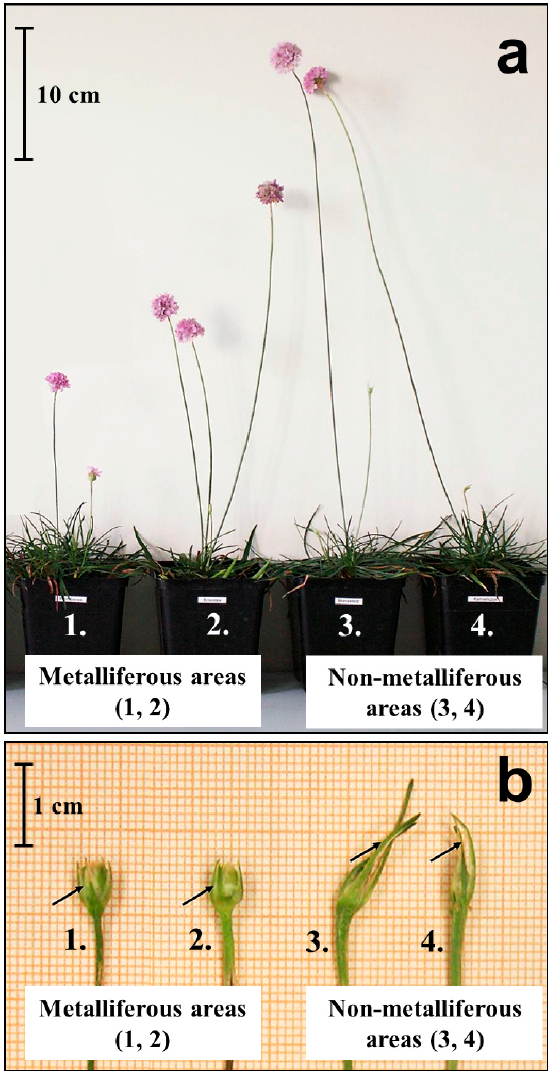
Figure 3. Morphological diversity of A. maritima plants grown in a greenhouse (generation F1) from seeds collected in metalliferous (1—zinc–lead slag heap from Plombières in Belgium; 2—zinc–lead waste heap from Boles ł aw in Poland) and non-metalliferous areas (3—meadow from northern Poland; 4—meadow from southern Poland). ( a ) The appearance of the whole plant. There are visible differences in the lengths of the generative shoots of plants from individual populations. Plants from metalliferous areas (1, 2) have shorter shoots than those from non- metalliferous areas (3, 4). ( b ) Inflorescence buds, where in plants from metalliferous areas (1, 2), the length of the outer involucral bracts of the inflorescence bud does not exceed the length of the bud (black arrows), while in plants from non-metalliferous areas (3, 4), it is twice as long as the bud (black arrows). All photos by Agnieszka Abratowska (based on Abratowska et al., 2015 [47], modified).